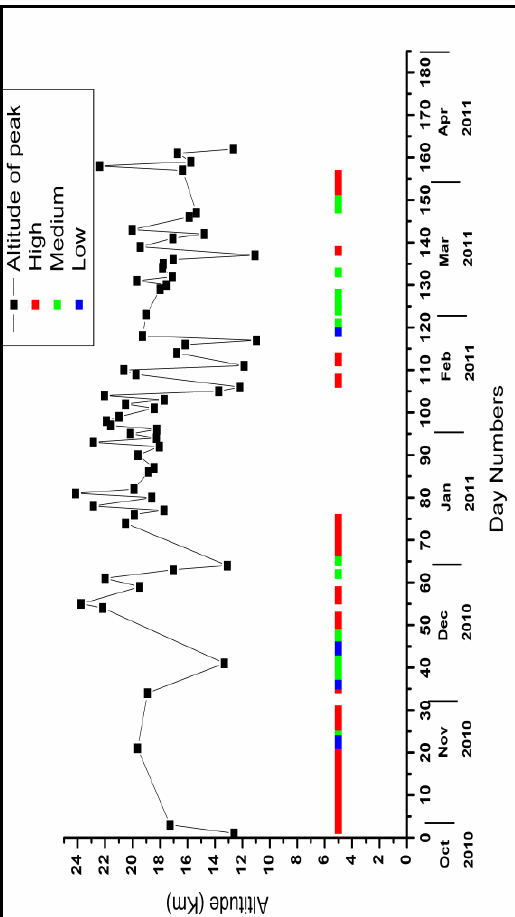
Figure-1: Comparison between altitude of Junge layer peaks and cloudy days